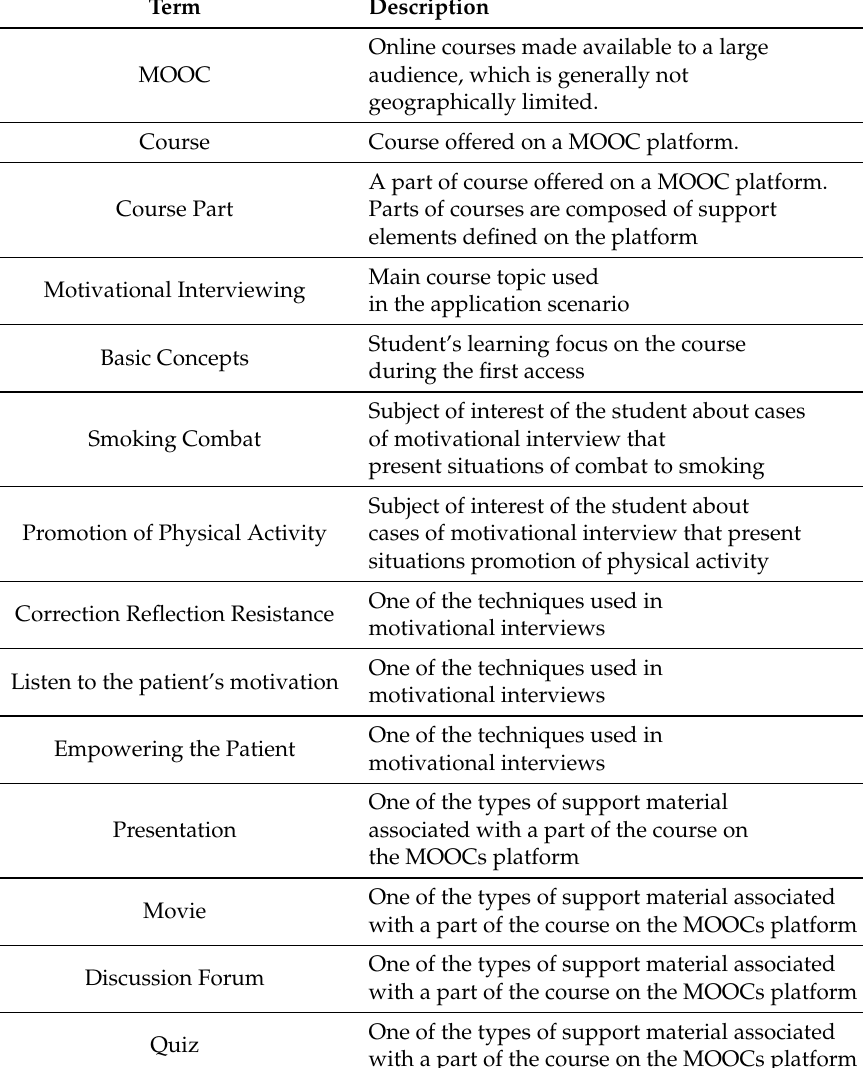
Table 5. Glossary of